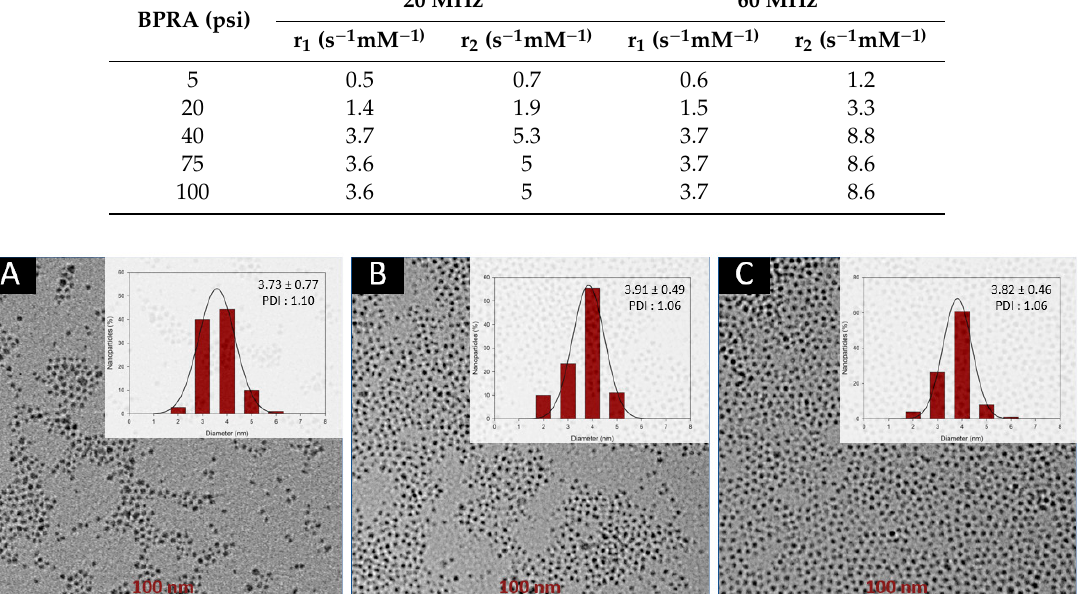
Table 1. Relaxometric properties of VSION obtained at different pressures.